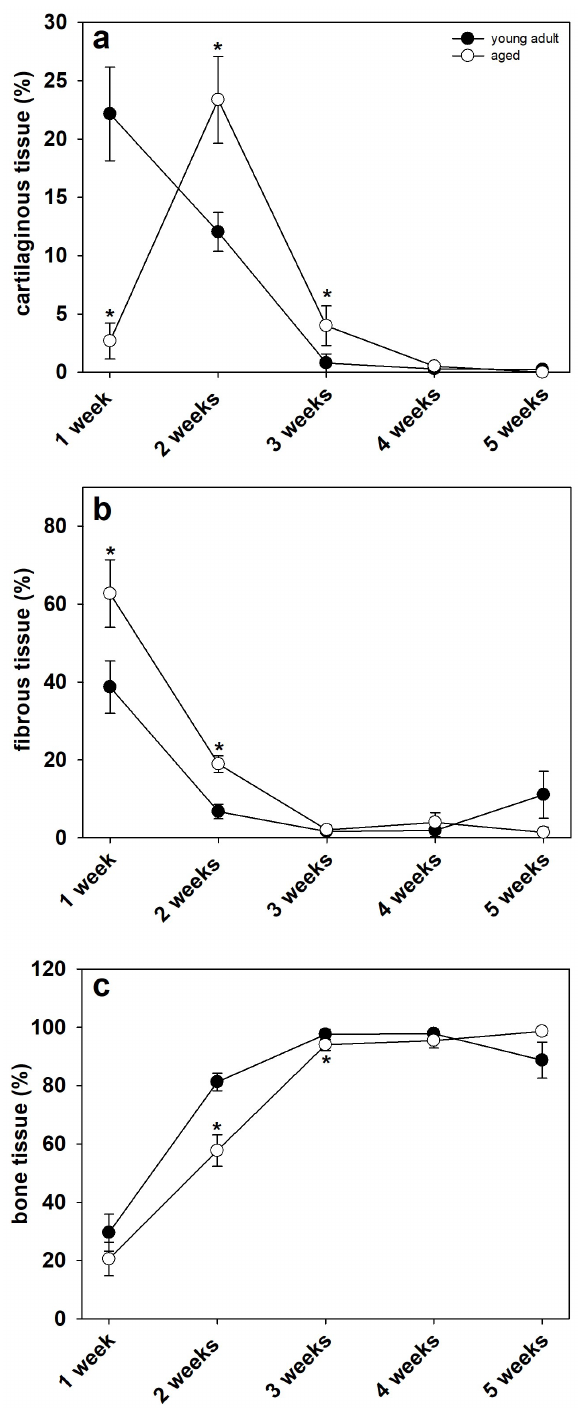
Figure 6. ( a ) Analysis of the ratio of cartilaginous tissue within the calluses of the fractured femora at 1, 2, 3, 4 and 5 weeks after fracture in young adult (black circles, n = 10) and aged (white circles, n = 10) CD-1 mice (Mann–Whitney U test used at 1, 3, 4 and 5 weeks, Student’s t -test used at 2 weeks). ( b ) Analysis of the ratio of fibrous tissue within the calluses of fractured femora at 1, 2, 3, 4 and 5 weeks after fracture in young adult (black circles, n = 10) and aged (white circles, n = 10) CD-1 mice (Student’s t -test used at 1 week, Mann–Whitney U test used at 2, 3, 4 and 5 weeks). ( c ) Analysis of the ratio of bone tissue within the callus tissue of fractured femora at 1, 2, 3, 4 and 5 weeks after fracture in young adult (black circles, n = 10) and aged (white circles, n = 10) CD-1 mice (Student’s t -test used at 1 and 2 weeks, Mann–Whitney U test used at 3, 4 and 5 weeks). Means ± SEM; * p < 0.05 vs. young